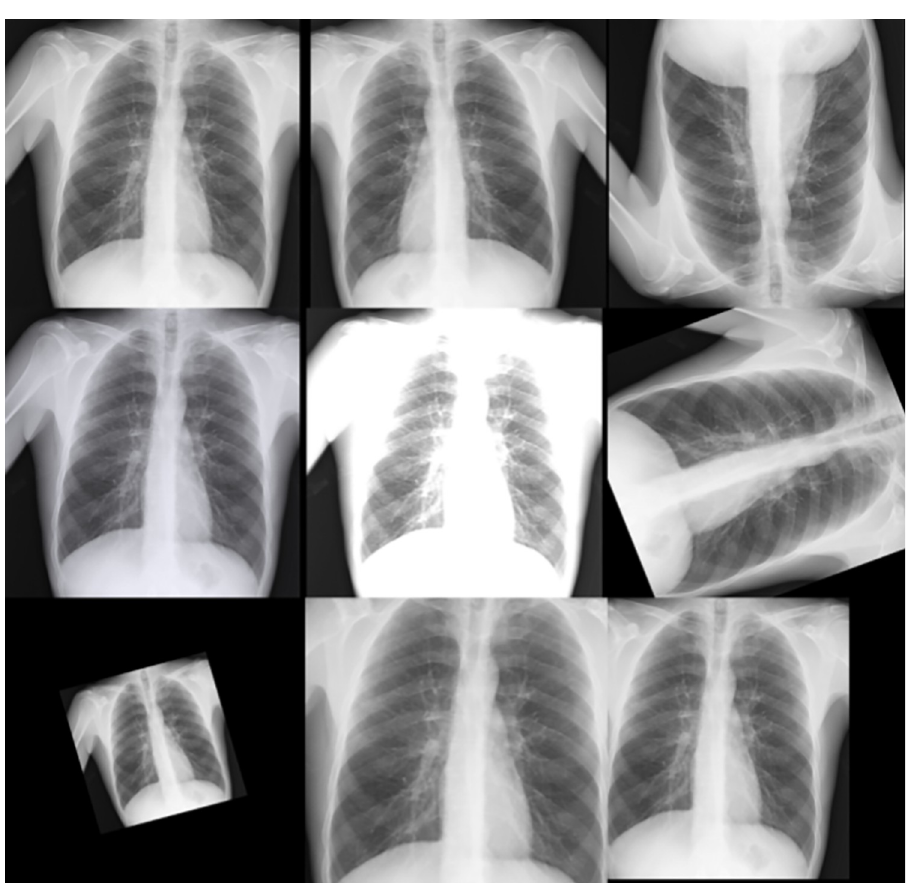
Fig 4. Image Augmentation [from Top to Bottom] Original, Horizontal Flipped, Vertical Flipped, Saturation, Contrast, Rotation, Shear, Zoom and Shift.